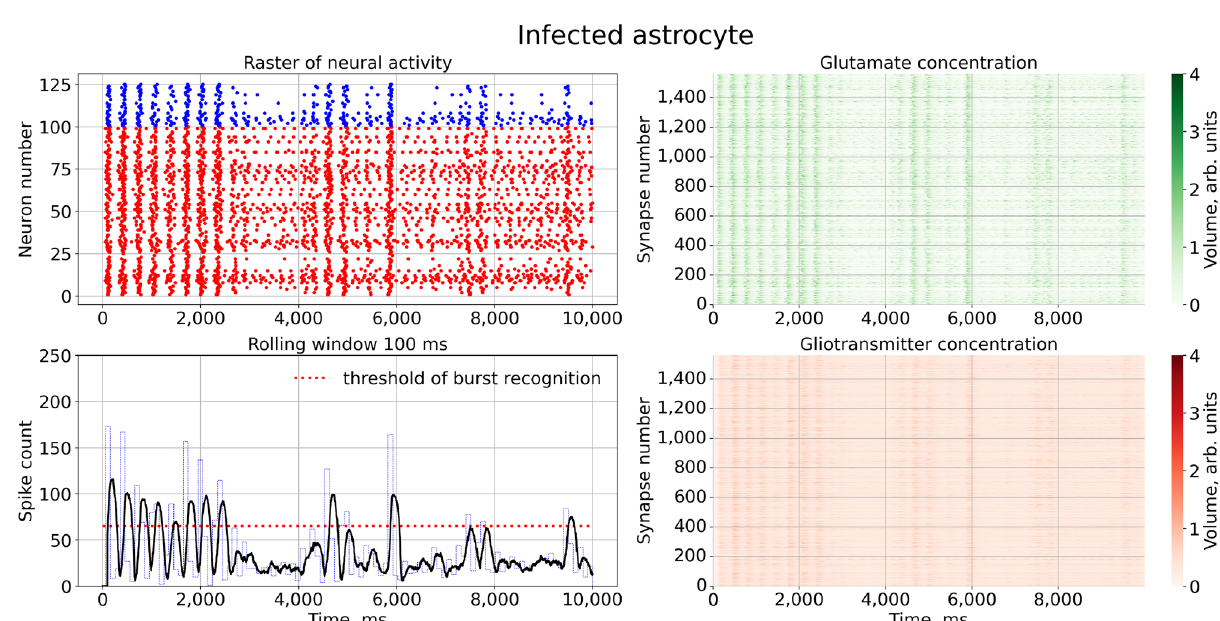
Figure 5. Raster chart of neural activity and dependences of gliotransmitter and neurotransmitter concentration from time with infected astrocyte feedbacks for γ virus = 0.2